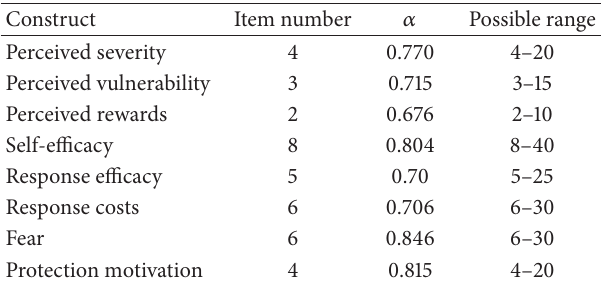
Table 1: Characteristics of PMT constructs